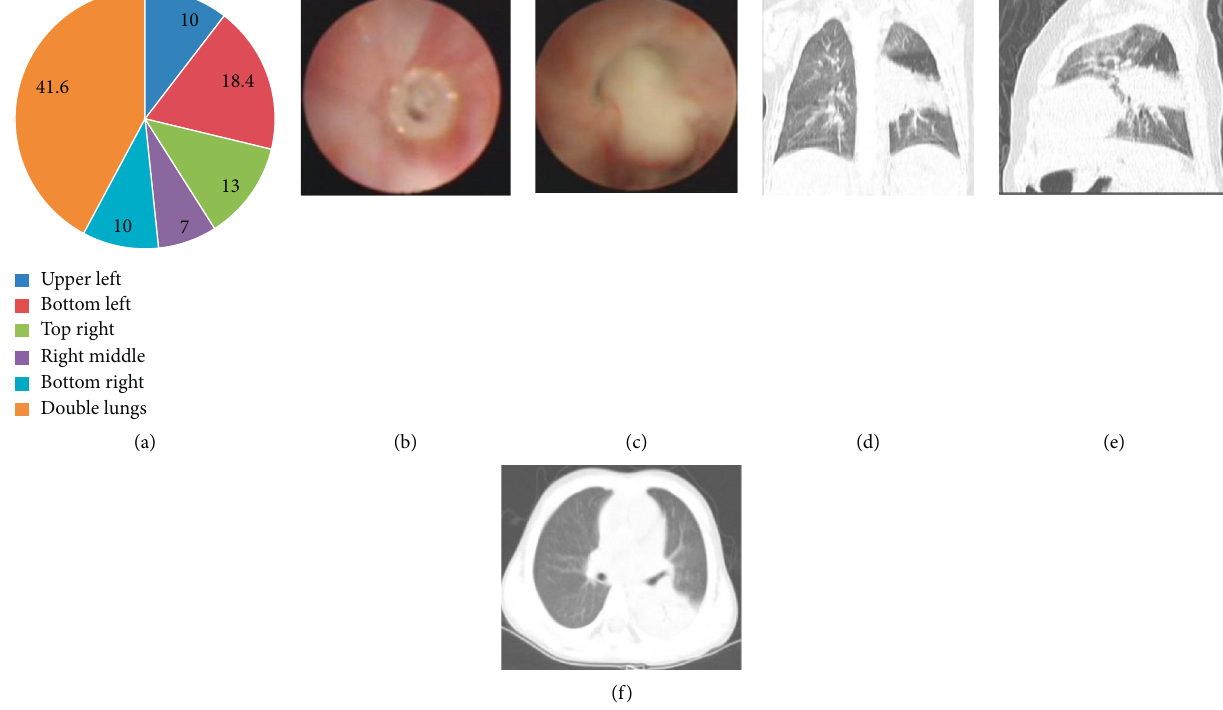
Figure 1: BMP formation distribution in the BMP group and the representative imaging features of a child with AdV pneumonia. (a) Distribution of mucus formation in the BMP group. (b, c) Representative pictures in bronchoscopy findings of the BMP of the annular stripping of the tracheal intima and the subbranch of the left lower basal branch. (d, e) The anteroposterior and lateral chest radiograph of the child. (f) The CT slice of the